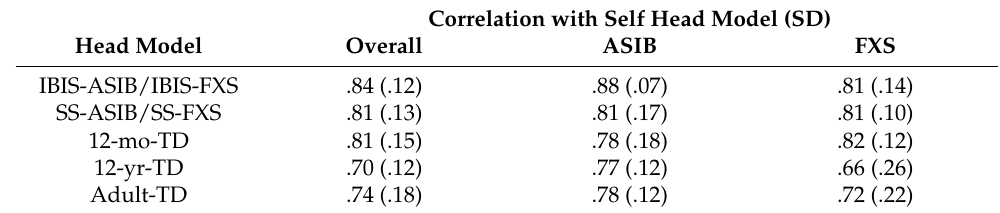
Table 4. Pearson correlations between CDR activation measured using the Self head model and average-template-derived head